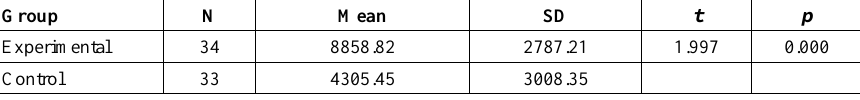
Table 6. Descriptive and t-test findings related to time spent